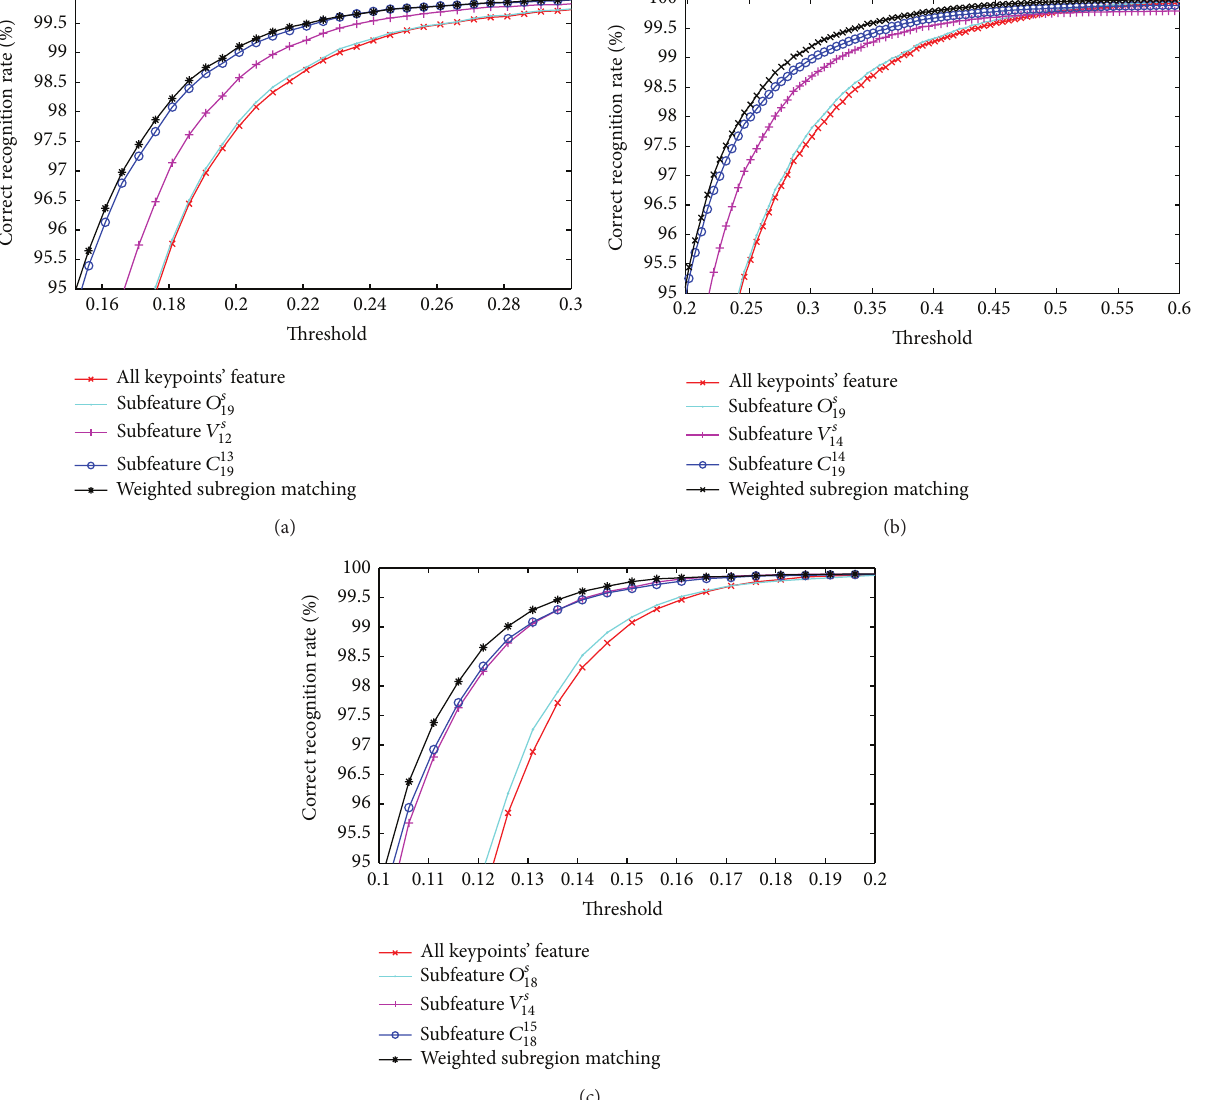
Figure 19: CRR curve of proposed methods under different threshold. (a) CRR curve for CASIA-V3 Interval, (b) CRR curve for CASIA-V3 Lamp, and (c) CRR curve for